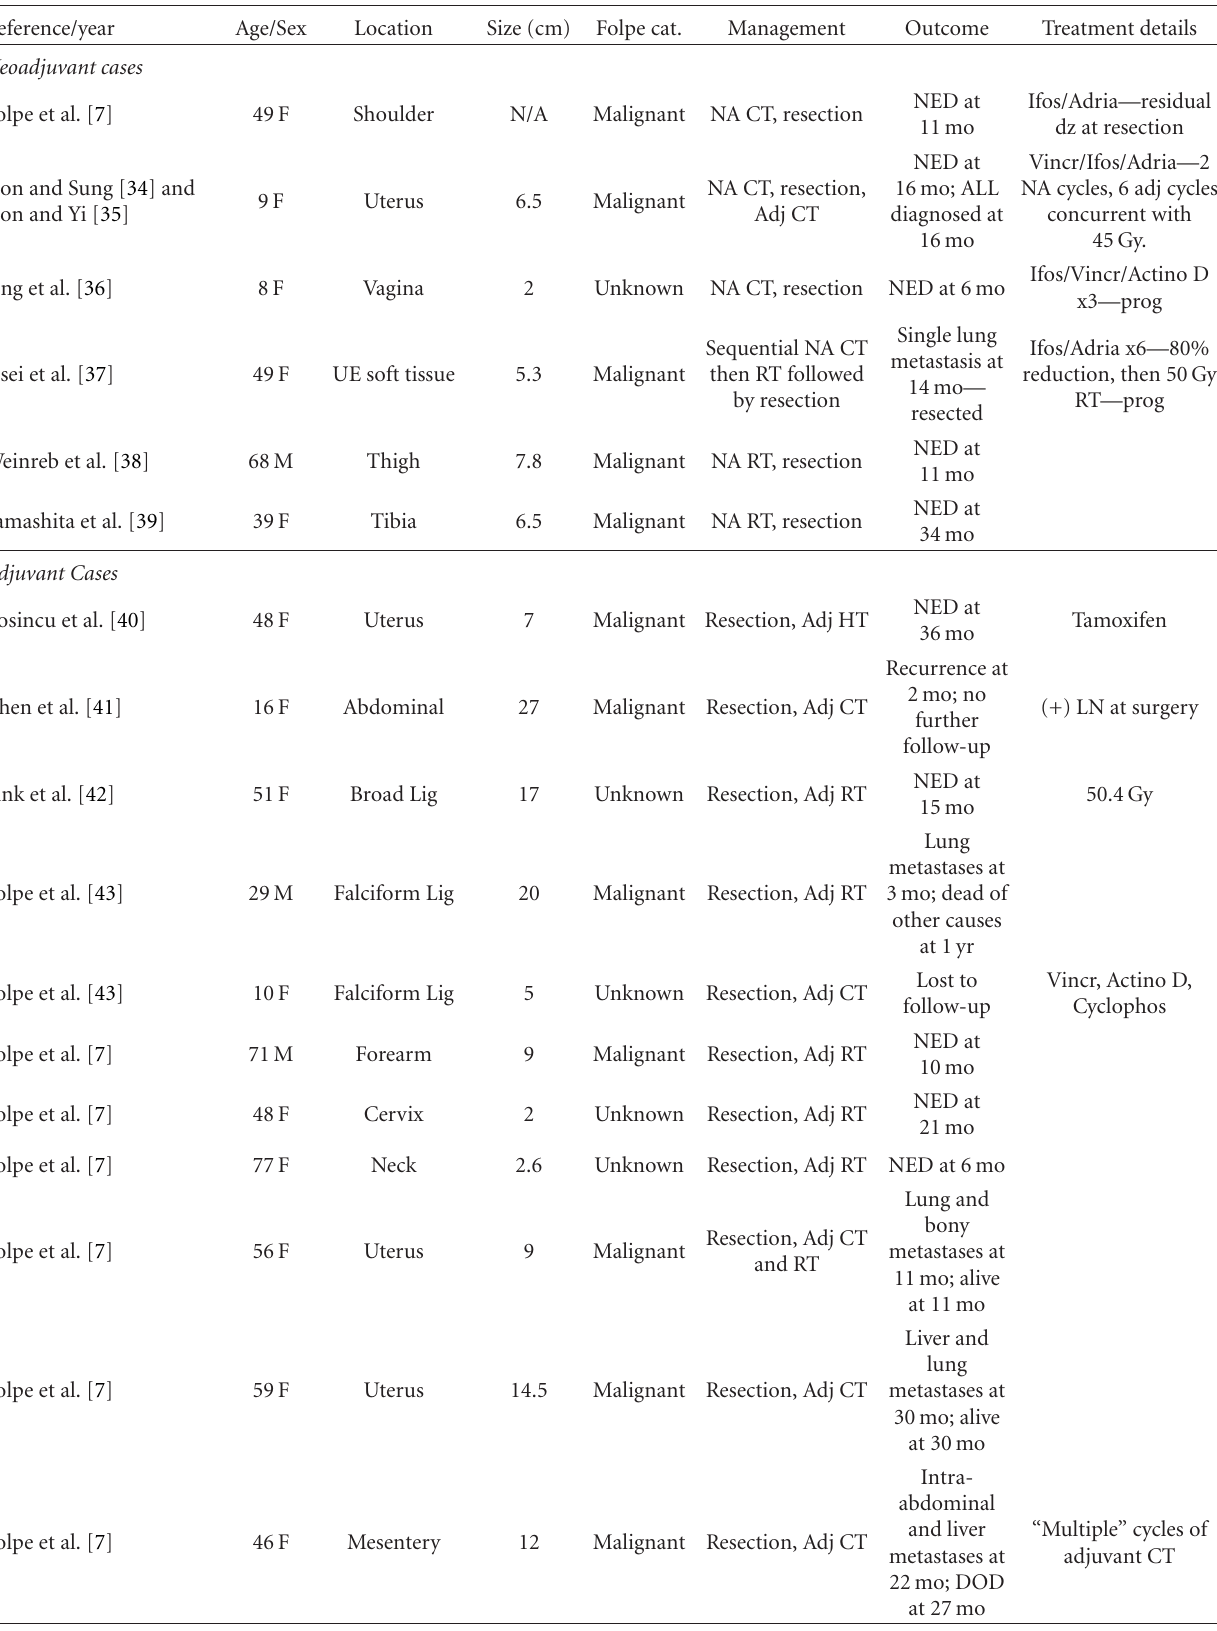
Table 5: Reported cases of non-surgical treatment of